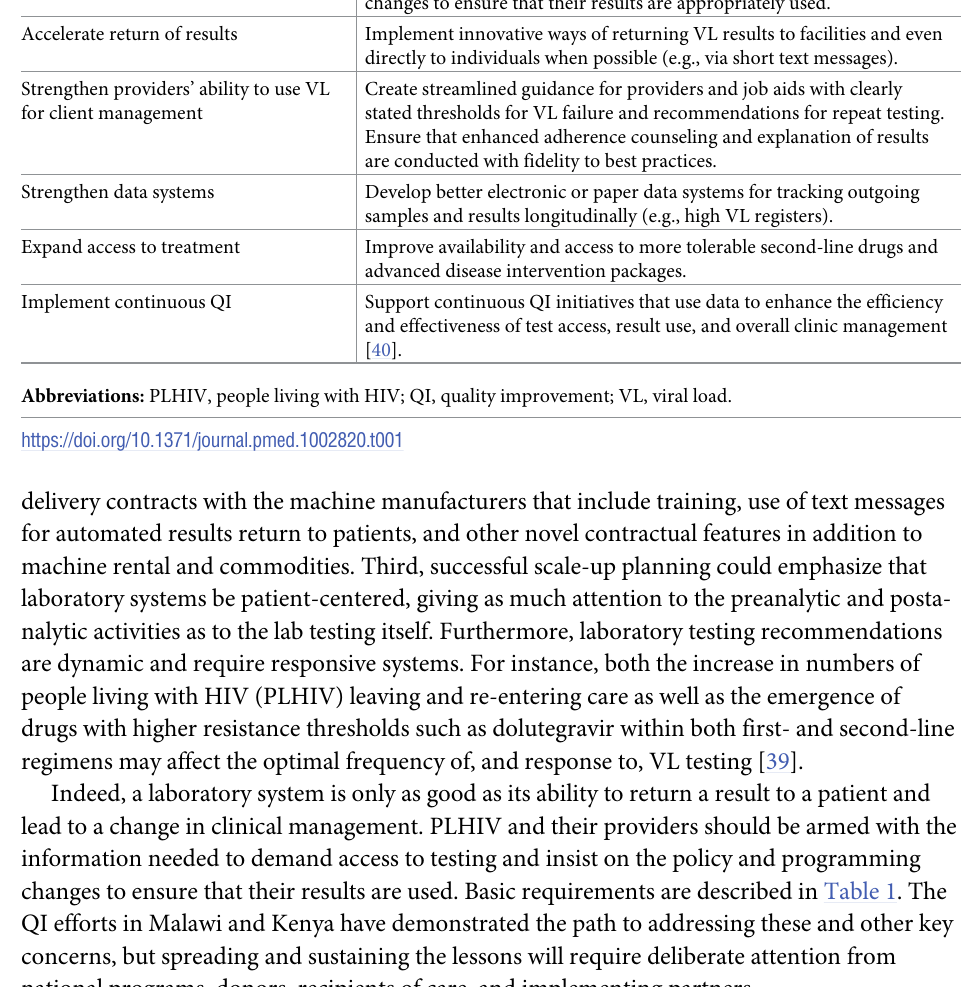
Table 1. Putting the patient at the center of the laboratory system to facilitate use of the results. Create demand and improve treatment